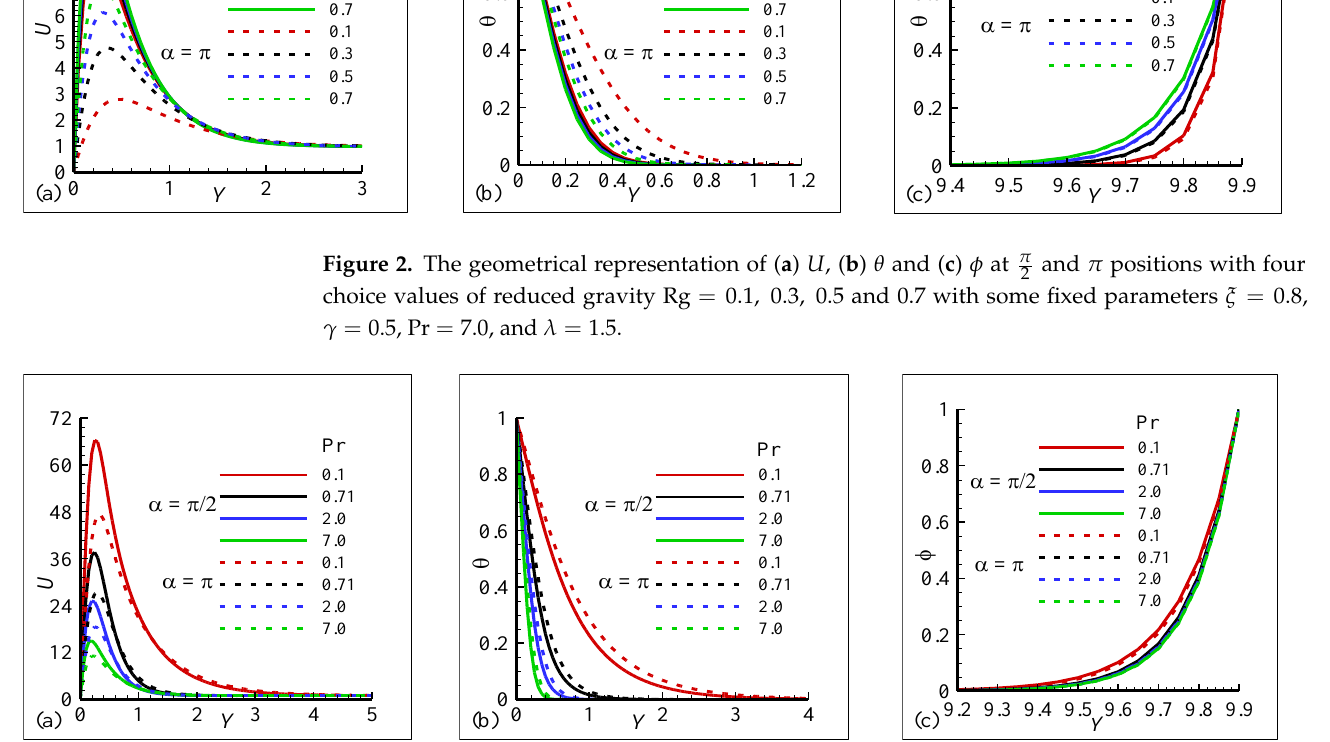
and π positions with four 2